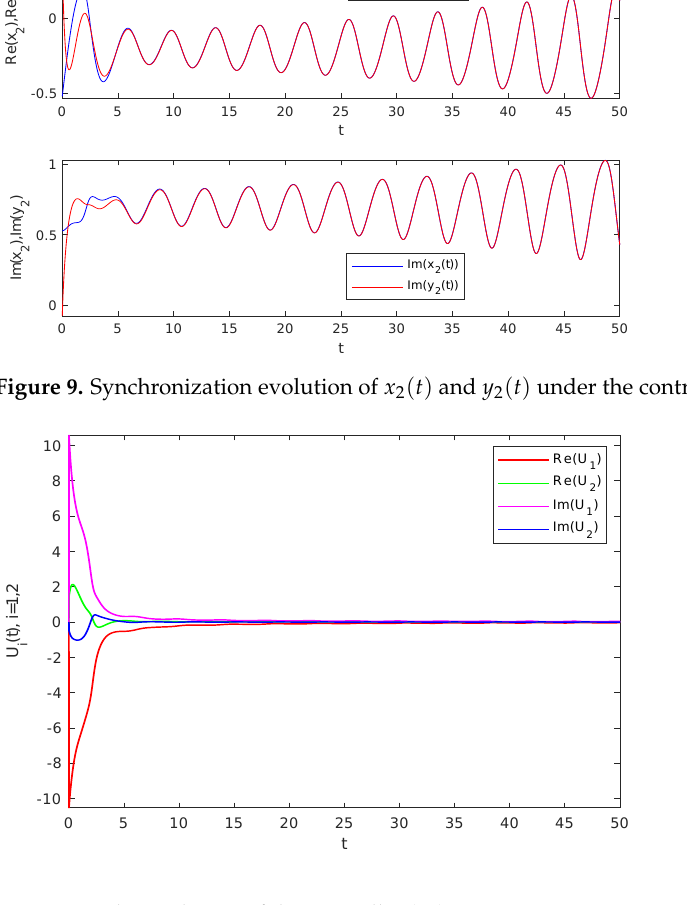
Figure 10. The evolution of the controller (18).